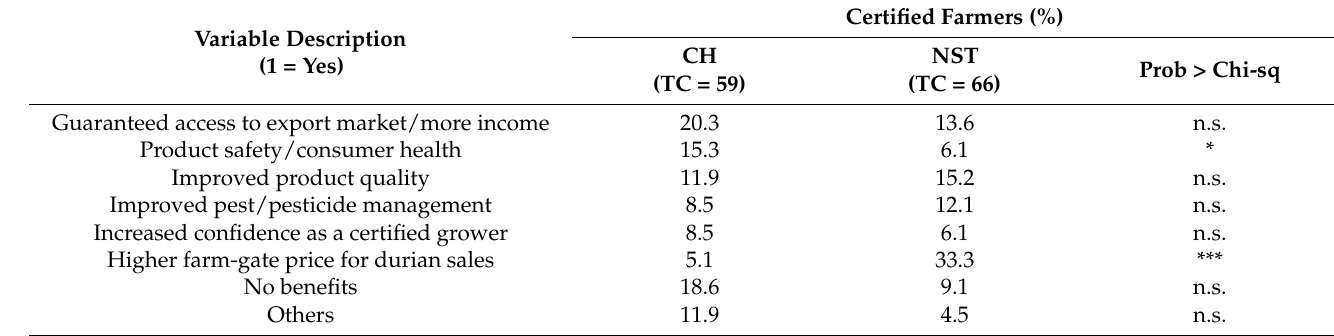
Table 3. Certified farmers’ views about the benefits of Q-GAP.